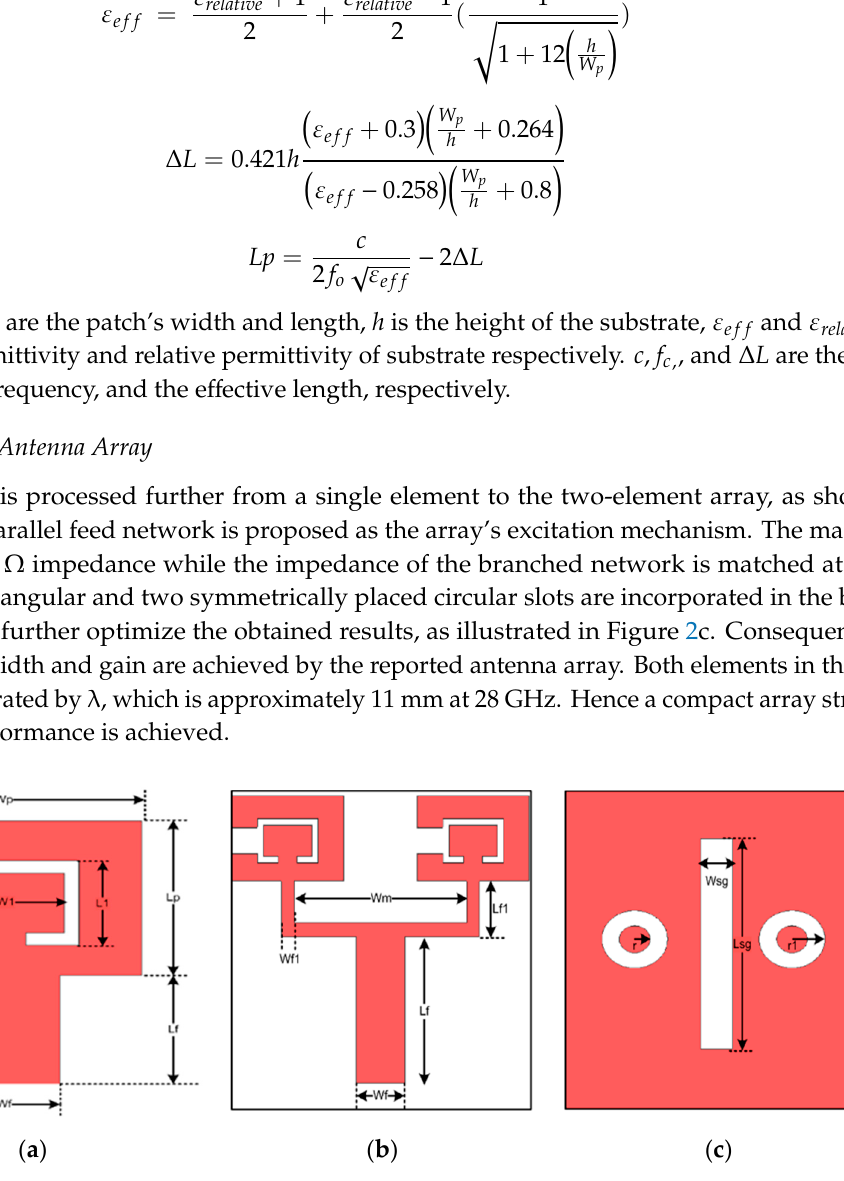
Figure 2. Proposed antenna geometry ( a ) Single element ( b ) Top layer of array antenna ( c ) Bottom layer.